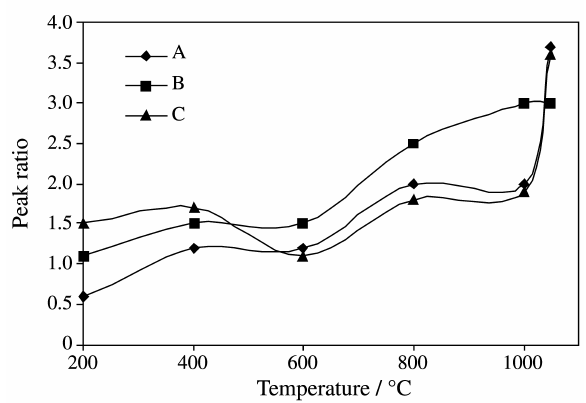
Figure 3. The ratiobetween the intensitiesof950 cm -1 band and 810 cm -1 band, showed in Fig. 1, as a function of temperature.